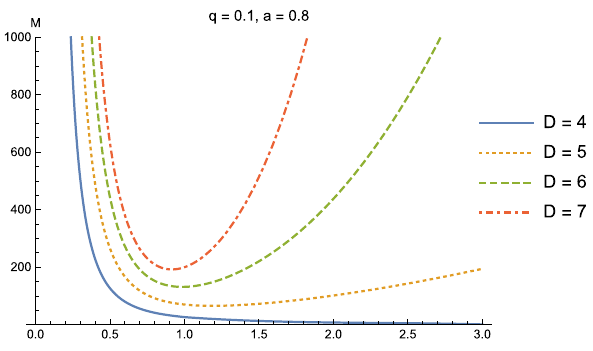
Fig. 14 Mass in third order Lovelock gravity as function of r h , for a = 0 . 8 and q = 0 . 1